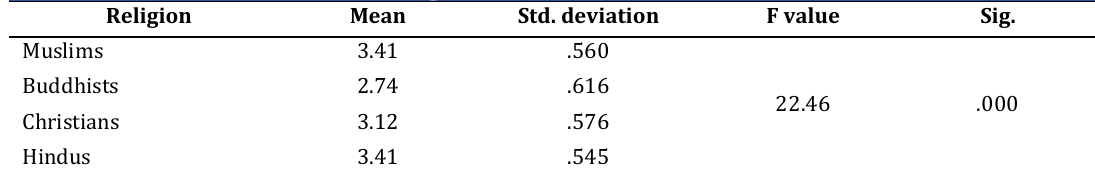
Table 4: The difference between religion and awareness of Shariah-based PRS Religion Mean Std. deviation F value Sig. Muslims 3.41 .560